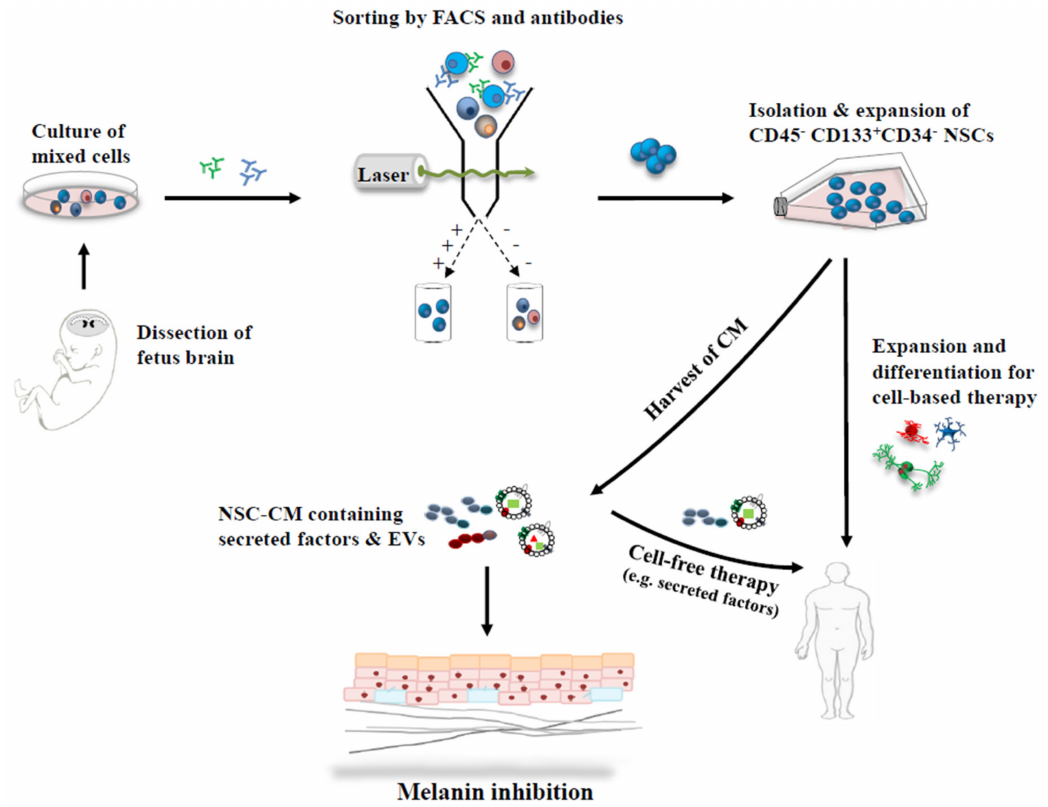
Figure 2. Strategic applications of stem cells and their derivatives, for skin depigmentation. CD45 − /CD133 + /CD34 − NSCs were isolated from the ventricular zone of human fetus brain by fluorescence-activated cell sorting and antibodies. NSCs transduced with retroviral vectors containing v-myc were expanded. They can differentiate into multiple lineages, neurons and glial cells, and can be applied to cell-based therapy and/or cell-free therapy using secreted factors. In addition, many factors including EVs are released in the medium during NSC cell culture, and they may modulate a microenvironment of skin tissue in a paracrine manner for melanin inhibition. FACS; fluorescence-activated cell